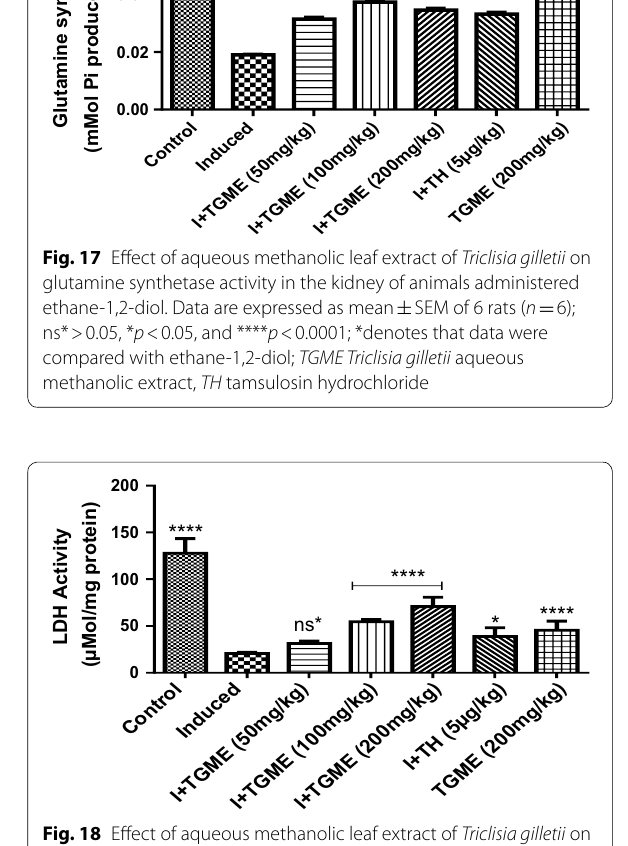
Fig. 16 Effect of aqueous methanolic leaf extract of Triclisia gilletii on Na–K ATPase activity in the kidney of animals administered ethane-1,2-diol. Data are expressed as mean *** p < 0.01, and **** p < 0.0001; *denotes that data were compared with ethane-1,2-diol; TGME Triclisia gilletii aqueous methanolic extract, TH tamsulosin hydrochloride